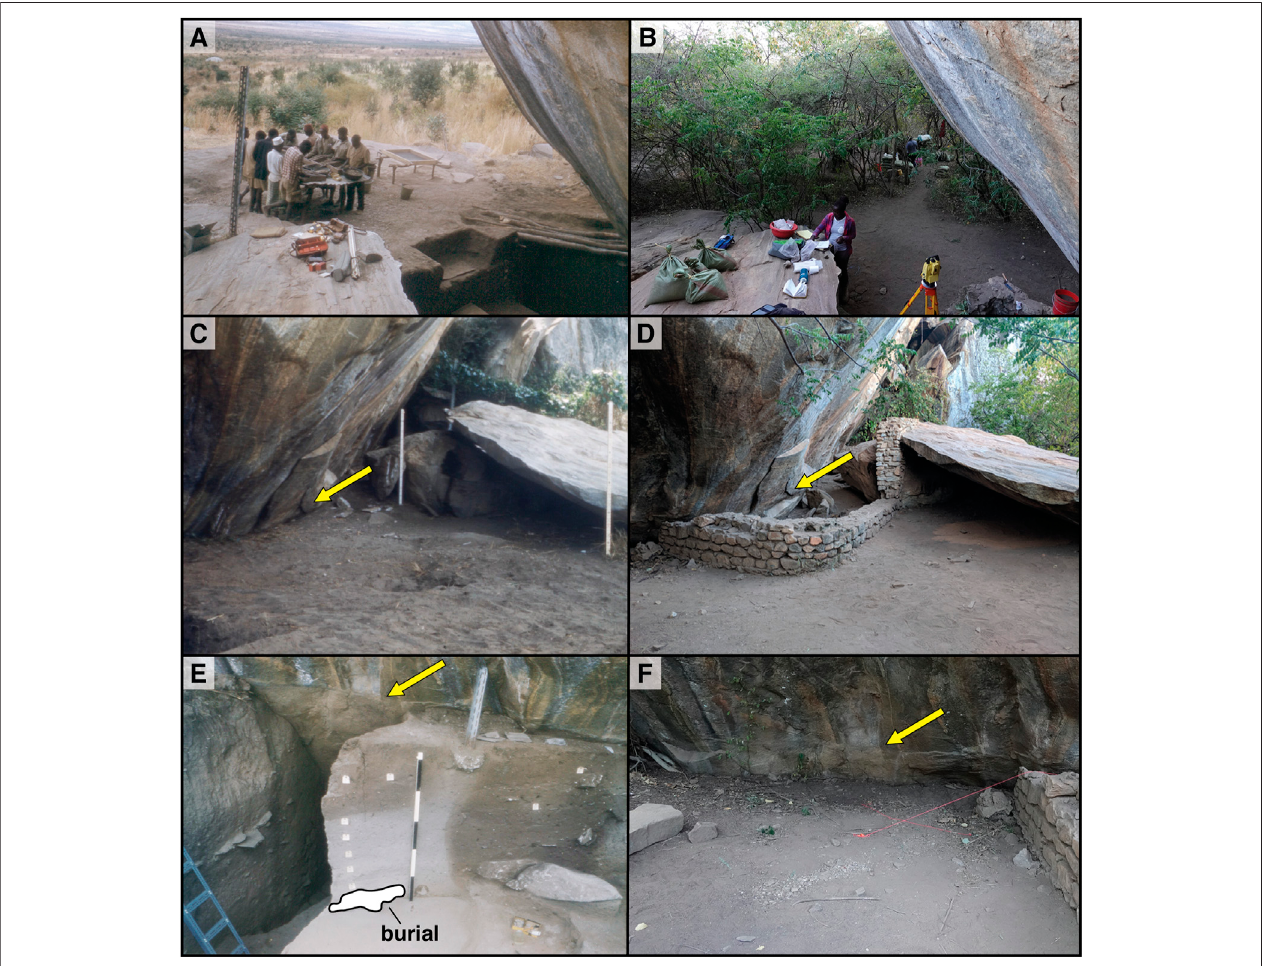
FIGURE 8 | Comparison of images taken during the 1956 Inkeep excavations (left column) and 2019 Ranhorn excavations (right column) showing changes at the site scale. (A , B) Viewofthesitefacing southwesttowardsboth thehistoricand modernscreeningareaandthelargegully totheSofthesitenotedin Figure2 .Note the dramaticchange intreecover. (C , D) Viewofthesite facingnorth.Yellow arrows indicate thepositionoftheweatheringlineontherock face, demonstrating theextentof sedimentlossatthebackwalloftheshelter. (E , F) Viewoftheshelterwallfacingwest.Yellowarrowsindicatethepositionofthesameweatheringfeatureontherock face, demonstrating the lateral extent of sediment